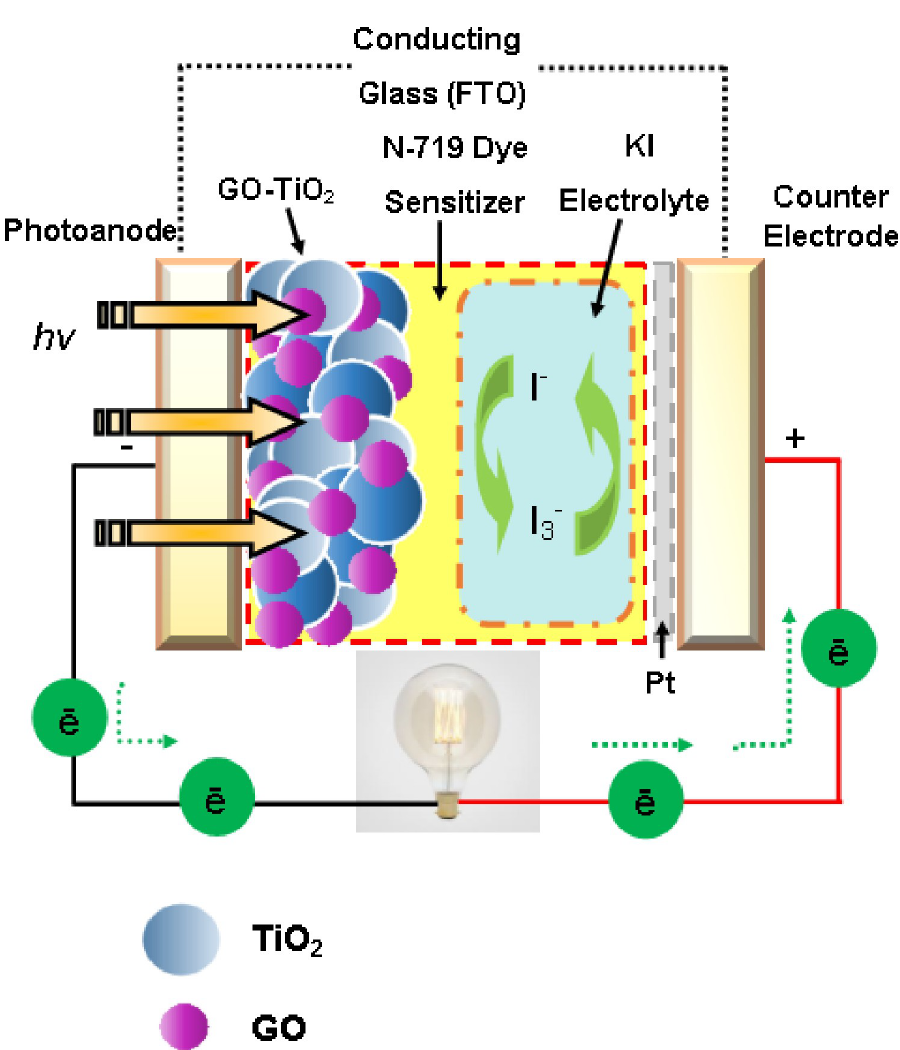
Fig 1. Schematic of GO72–TiO 2 nanocomposite-based photoanode in DSSCs.